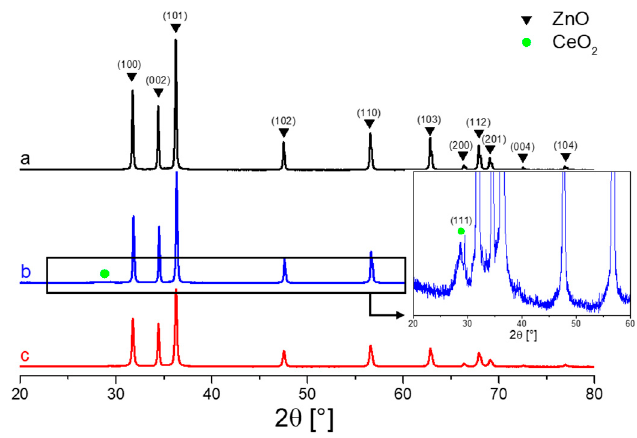
Figure 1. X-rays pattern diffraction of: ( a ) ZnO, ( b ) CZ1 and ( c ) YZ1.